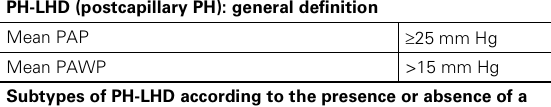
Table 2: Haemodynamic definitions of pulmonary hypertension associated with left-sided heart disease according to [1]. PH-LHD (postcapillary PH): general definition Mean PAP ≥ 25 mm Hg Mean PAWP >15 mm Hg Subtypes of PH-LHD according to the presence or absence of a pre-capillary component Isolated postcapillary PH DPG And/or